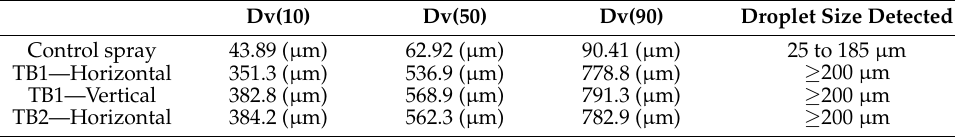
Table 1. Distribution statistics for TB1, TB2 and control